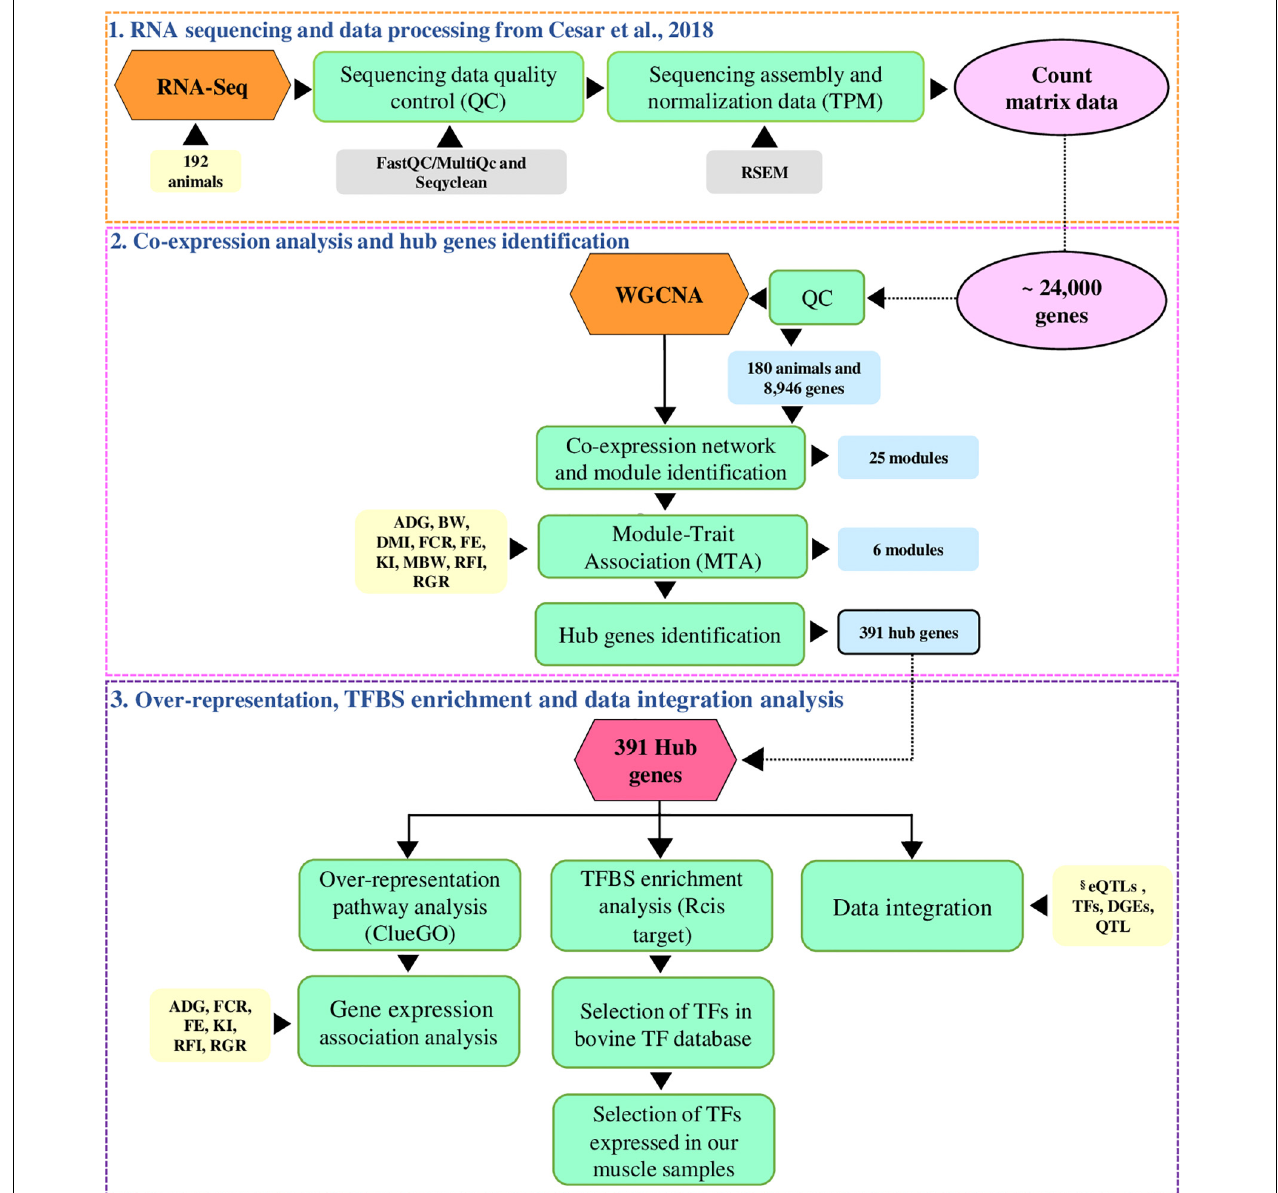
FIGURE 1 | Overview of the analysis. The analysis workflow is separated into three parts. (1) The orange dashed box corresponds to the RNA sequencing and data processing performed by Cesar et al. (2018). (2) The pink dashed box corresponds to the co-expression network construction and the hub genes identification. (3) The purple dashed box corresponds to the over-representation, transcription factor binding site (TFBS) enrichment analysis, and data integration analysis. The steps taken are described in the green boxes, the count matrix represented by the pink circle, the yellow boxes are the input, the light blue boxes are the output in each step, and the gray boxes are the tools used in each step. ADG = average daily gain; BW = body weight; DMI = dry matter intake; FCR = feed conversion ratio, FE = feed efficiency ratio; KI = Kleiber index, MBW = metabolic body weight, RFI = residual feed intake, RGR = relative growth ratio. §Database used in our study derived from eQTL analysis (Cesar et al., 2018); manually curated transcription factors (TFs) bovine database (de Souza et al., 2018); differentially expressed genes (DEGs) in muscle for RFI (Tizioto et al., 2016); feed efficiency QTL (de Oliveira et al., 2014).